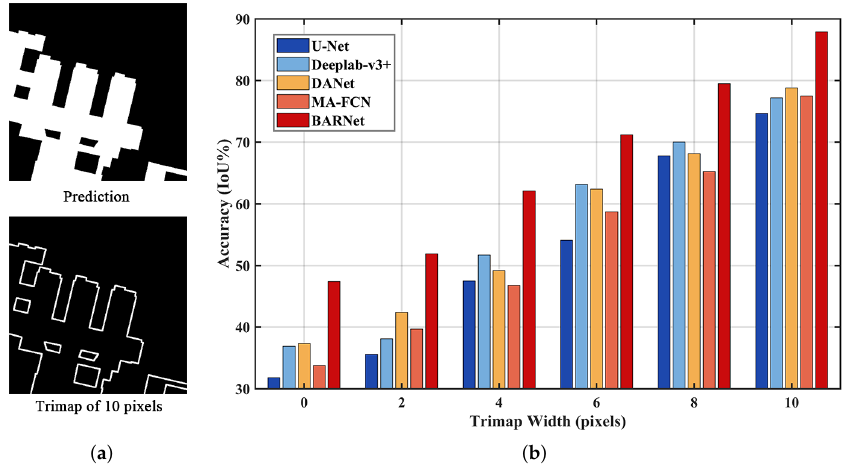
Figure 11. Instance of a trimap and comparisons of boundary refinement. ( a ) Boundary trimap. ( b ) Mean IoU results for trimap experiments with a bandwidth of { 2,4,6,8,10,12 }